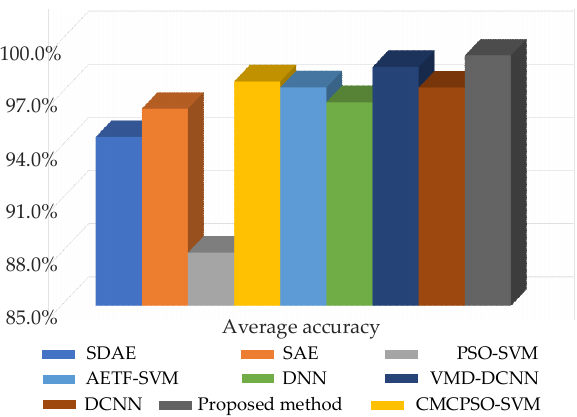
Figure 13. The testing diagnostic accuracy of different diagnostic methods.